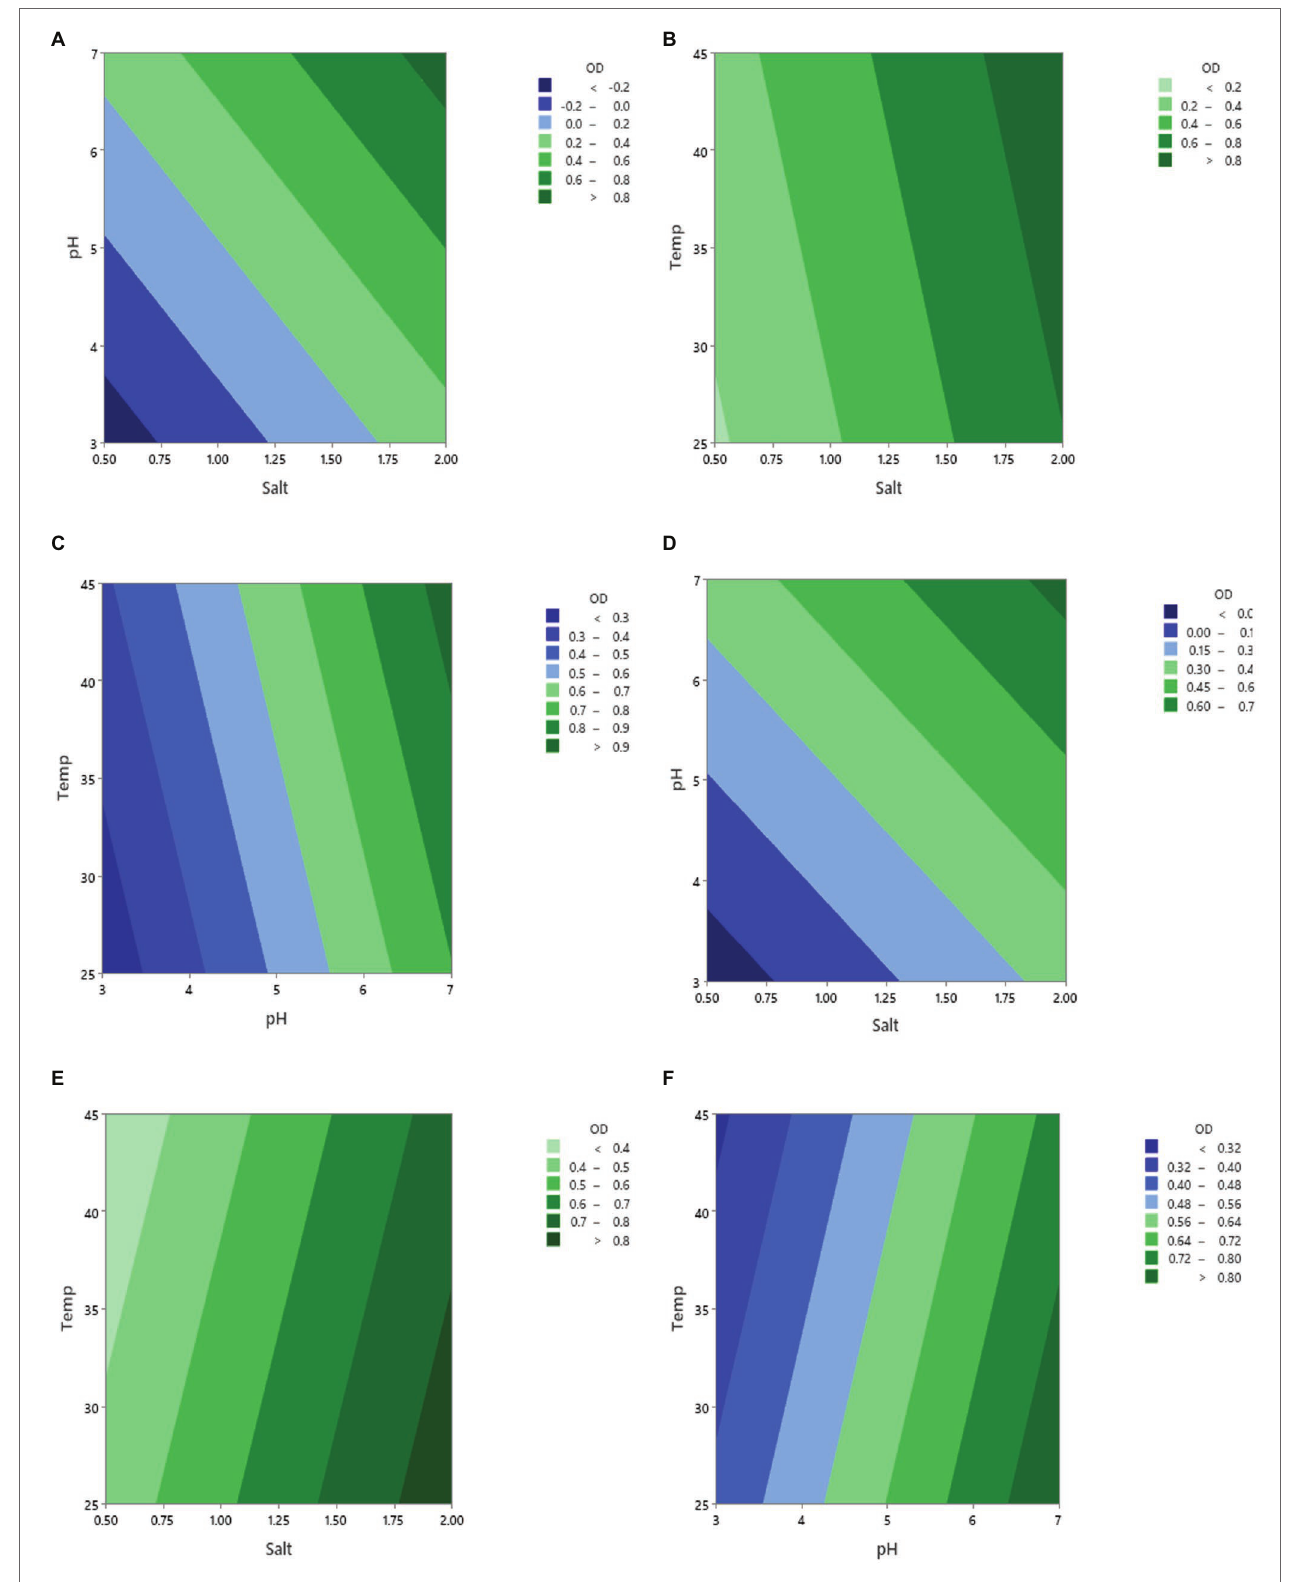
FIGURE 2 | Contour plots of the growth (OD) of vibrio spp. isolated from fish (A–C) and shellfish (D–F) during changing three factors (pH, salt, and temperature) and incubation for 16 h. The fixed values of each factor were 2.0 for salt, 7.0 for pH, and 37 ° C for